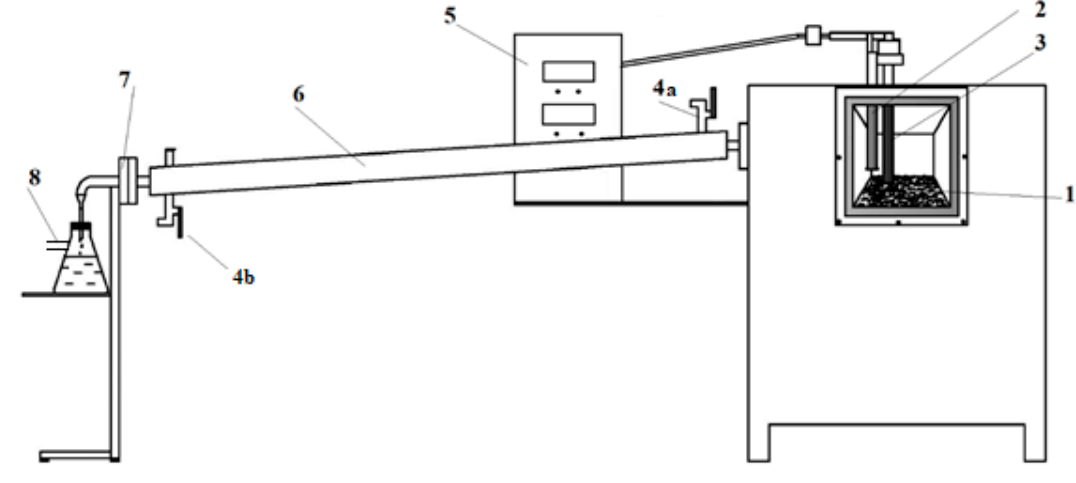
Figure 2. Scheme of the reactor used to pyrolyze WPBs; 1—bed, 2—thermocouples, 3—safety valve, 4—cooling water (a) inlet and (b) outlet, 5—control device, 6—gas cooler, 7—output used to collect process gases, 8—liquid fraction vessel.